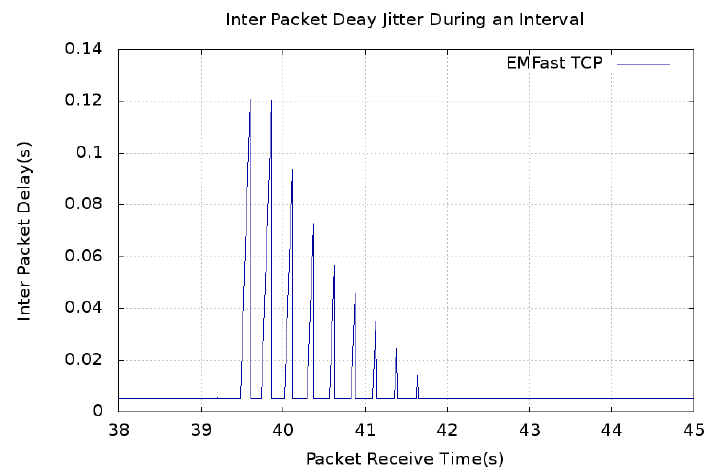
Figure 10. Inter-packet delay jitter during and after fast-retransmit and -recovery phases of Enhanced Multistream Fast Transmission Control Protocol (EMFast TCP).